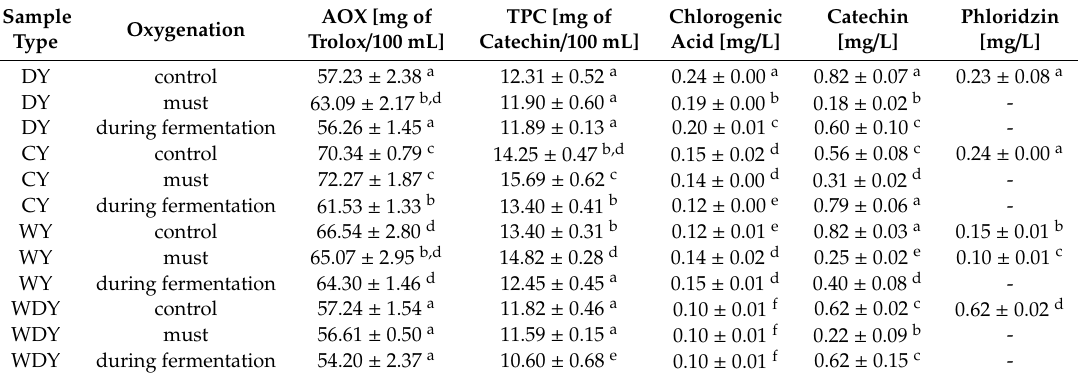
Table 2. Impact of the type of oxygenation on polyphenol content and antioxidant activity of ciders. Sample